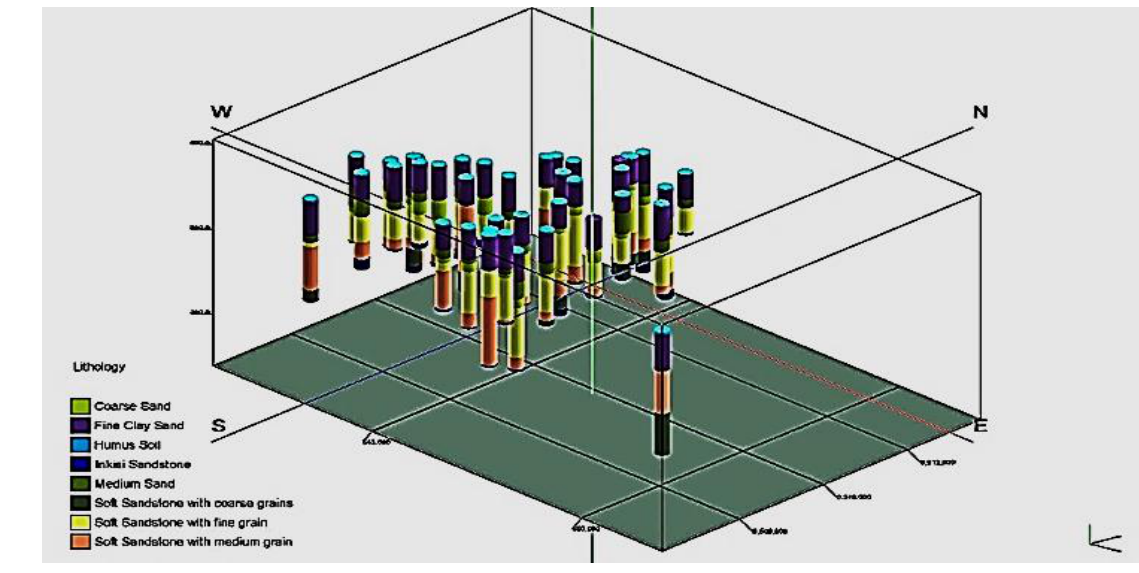
Figure 11. 3D Borehole location.